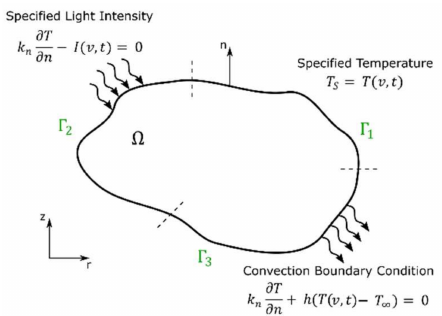
Figure 26. Schematic representation of the thermal-kinetic boundary conditions considered for the different regions Γ 1 , Γ 2 , Γ 3 of the domain Ω . Redrawn from reference